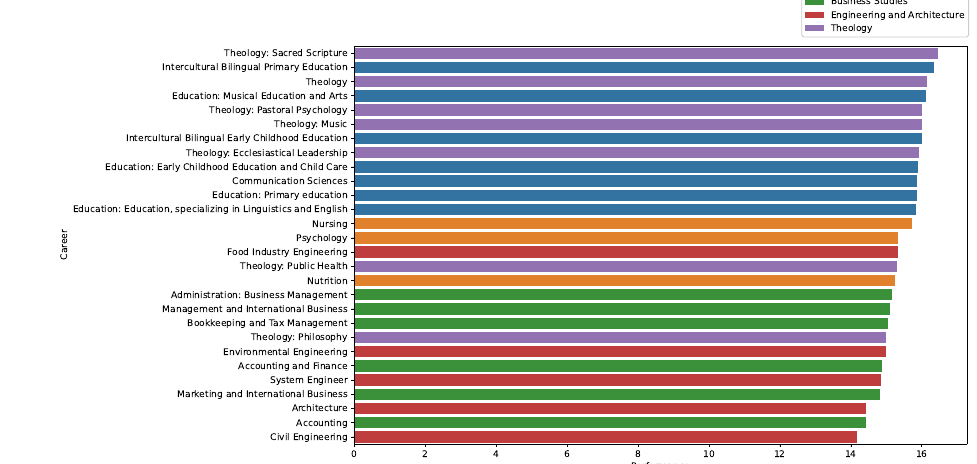
Figure 3. Average of qualifications according to professional career and